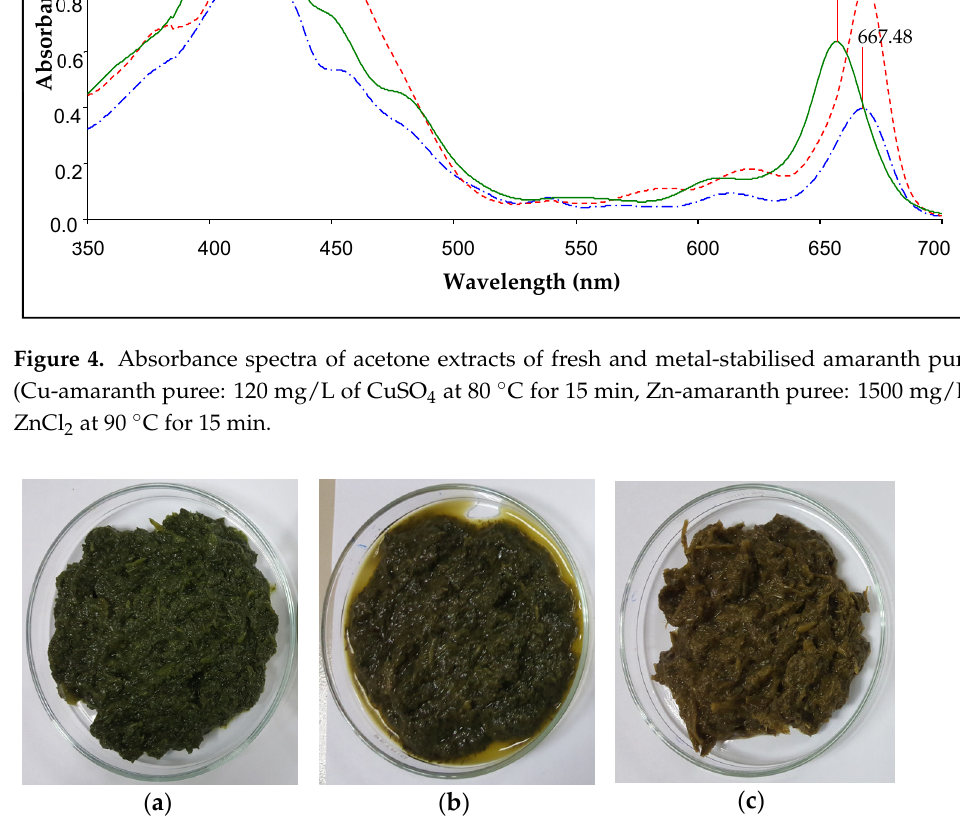
Figure 5. Amaranth purees of ( a ) Cu-amaranth puree stabilised at pH 6 and 80 °C for 15 min with 210 mg/L of CuSO 4 , ( b ) Zn-amaranth puree stabilised at pH 8 and 90 °C for 15 min with 1500 mg/L ZnCl 2 , and ( c ) control amaranth puree (0 mg/L of Zn or Cu and heated at 80 °C for 15 min).